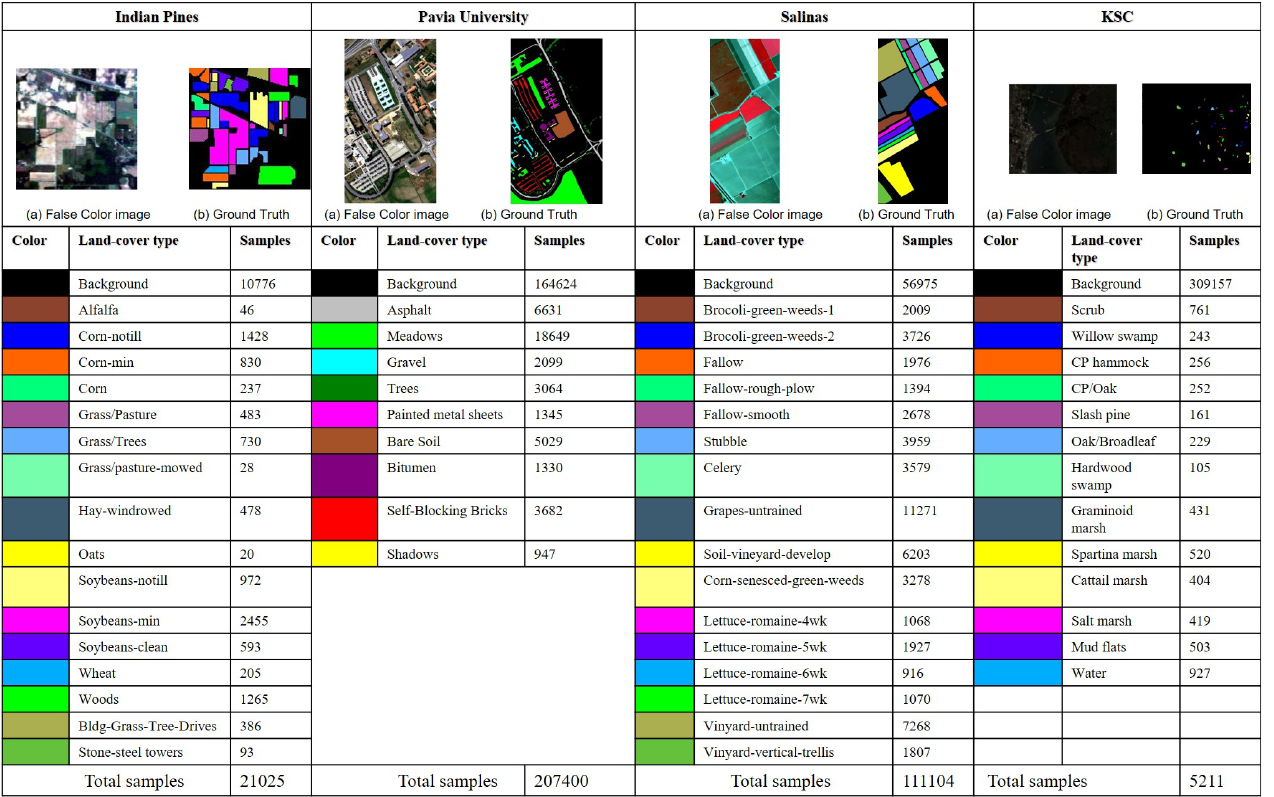
Figure 6. Details of the Indian Pines, Pavia University, and Salinas HSI data sets. They include the false color images, ground truths, and numbers of samples per